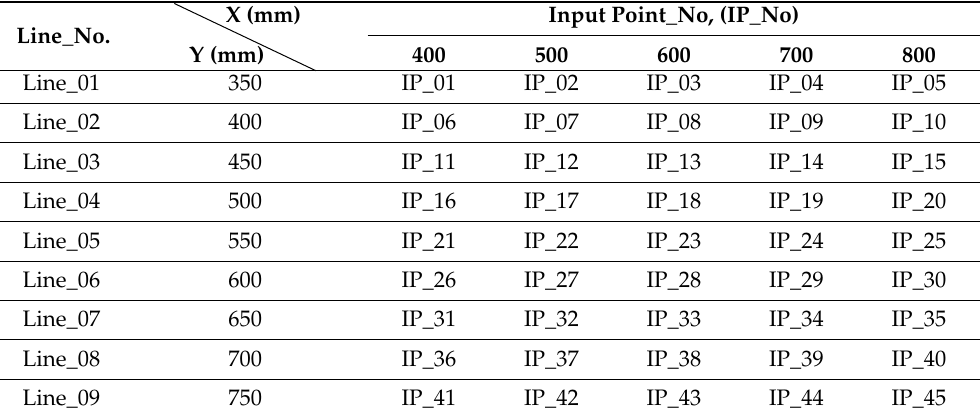
−1.5−1.0−0.50.00.51.0 Figure 12. Example of response waveform after normalization (Case_1: φ s = 63 mm).